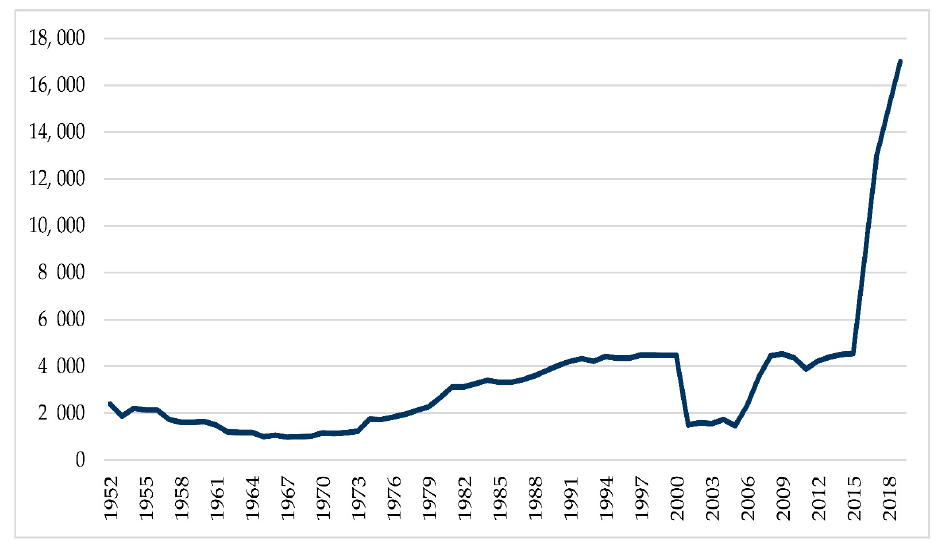
Figure A6. Li price dynamics, battery-grade lithium carbonate, in USD/t (build on the data from [25]).